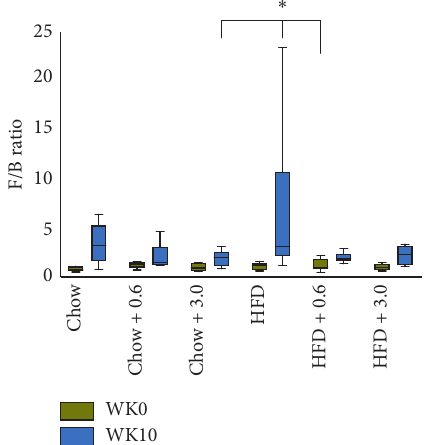
Figure 10: Firmicutes-to-Bacteroidetes ratio of all groups at week 0 and week 10. Data were analyzed by two-way ANOVA RM fol- lowed by Tukey post hoc test, ∗ denotes p < 0 . 0355 and p � 0 . 0416 compared to Chow+ 3.0mg/mL and HFD+0.6mg/mL F/B ratio at week 10, respectively ( n �